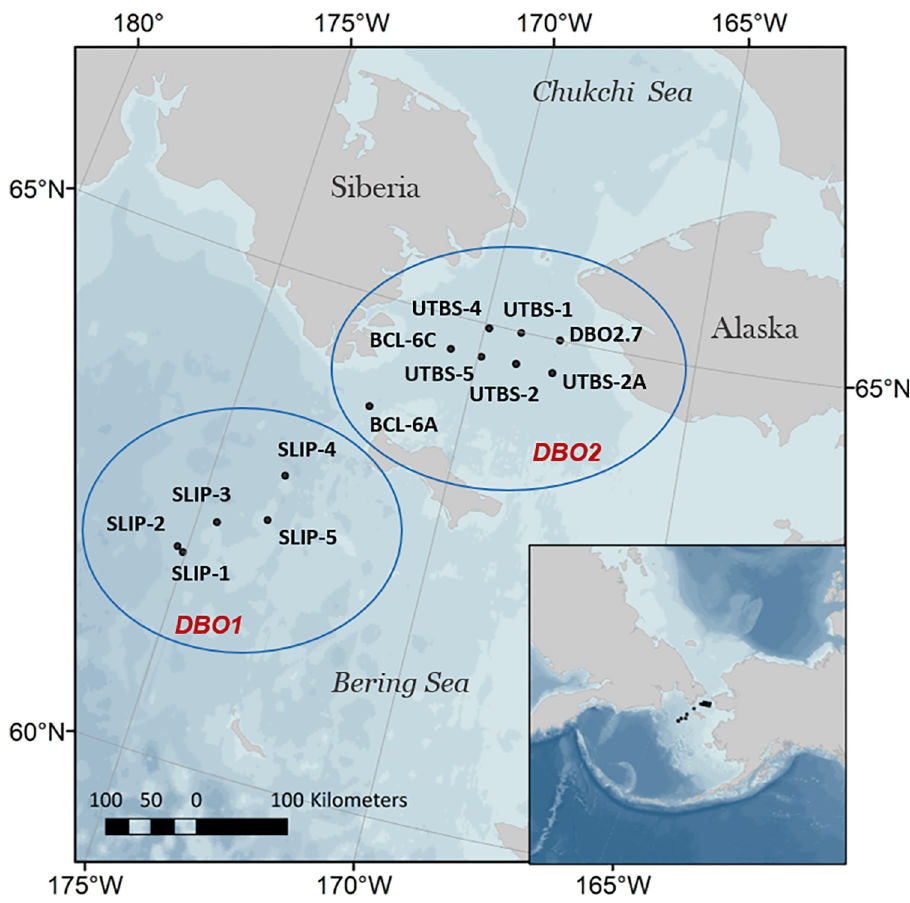
Fig 1. Map of the northern Bering Sea study area. Two DBO areas are indicated in red and the black text corresponds to individually sampled stations within each DBO transect marked by the blue circles. The stations are grouped as DBO1 (n = 5: SLIP-1, SLIP-2, SLIP-3, SLIP-4, SLIP-5) and DBO2 (n = 8: BCL-6A, BCL-6C, UTBS-1, UTBS-2, UTBS-3, UTBS-4, UTBS-5, DBO2.7). The bathymetry is reproduced from GEBCO Sheet G.08 compiled by R. L. Fisher of the Scripps Institution of Oceanography and extracted from the GEBCO Digital Atlas published by the British Oceanographic Data Centre on behalf of the IOC and IHO, 2003.